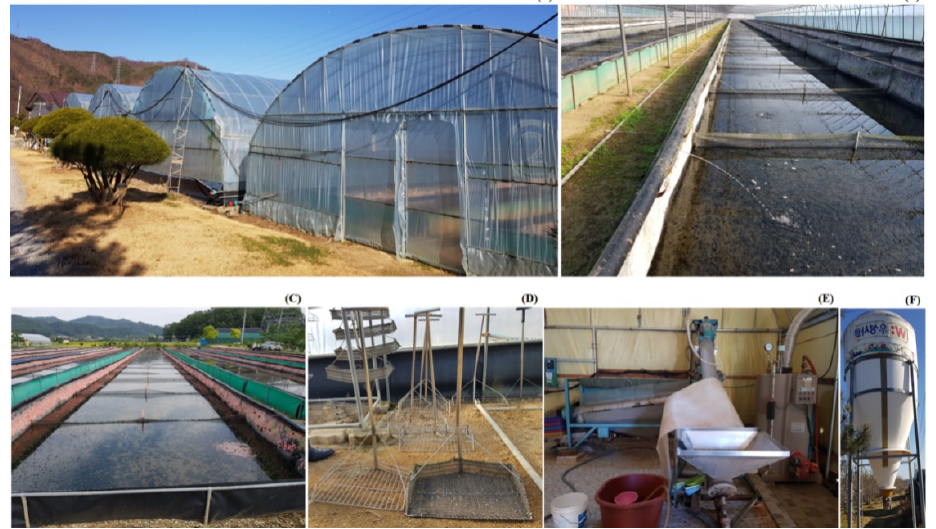
Figure 2. Snail farm in Andong (Republic of Korea): ( A ) Tunnel house for Pomacea canaliculata snail farming in winter; ( B ) pen for snail rearing; ( C ) open farming system during summer; ( D ) differently-sized steel mesh sheets used to separate snails based on size; ( E , F ) feed manufacturing unit of the farm.